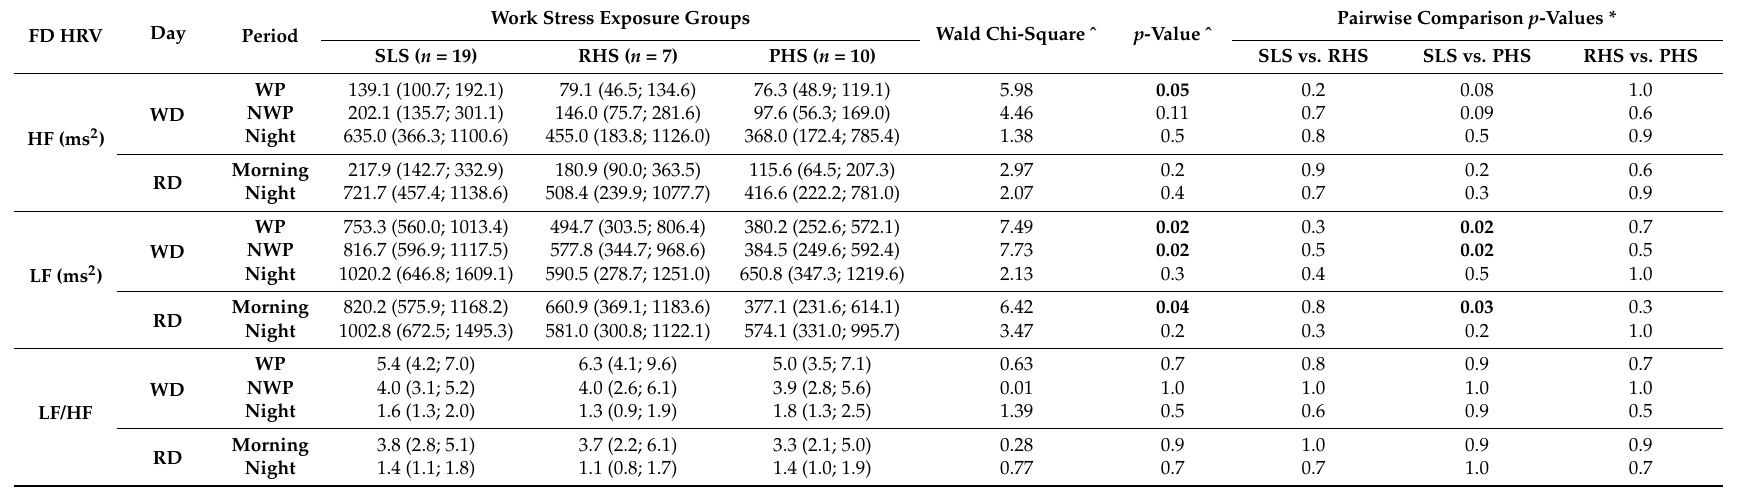
Table 2. Age- and smoking-adjusted geometric mean (95% CI) for Frequency Domain HRV parameters in different periods of the working and of the resting days, by work stress